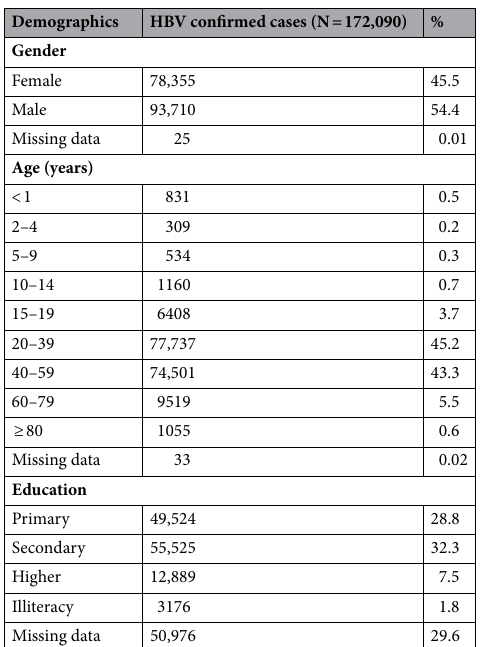
Table 1. Demographic characteristics of individuals affected by Hepatitis B virus infection in Brazil during 2007–2018.